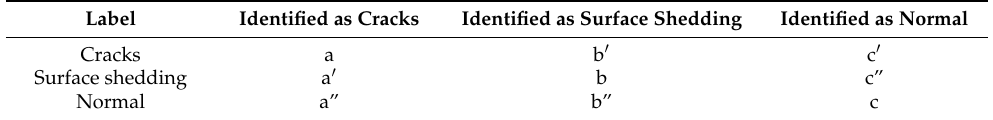
Table 1. Confusion matrix for surface damage